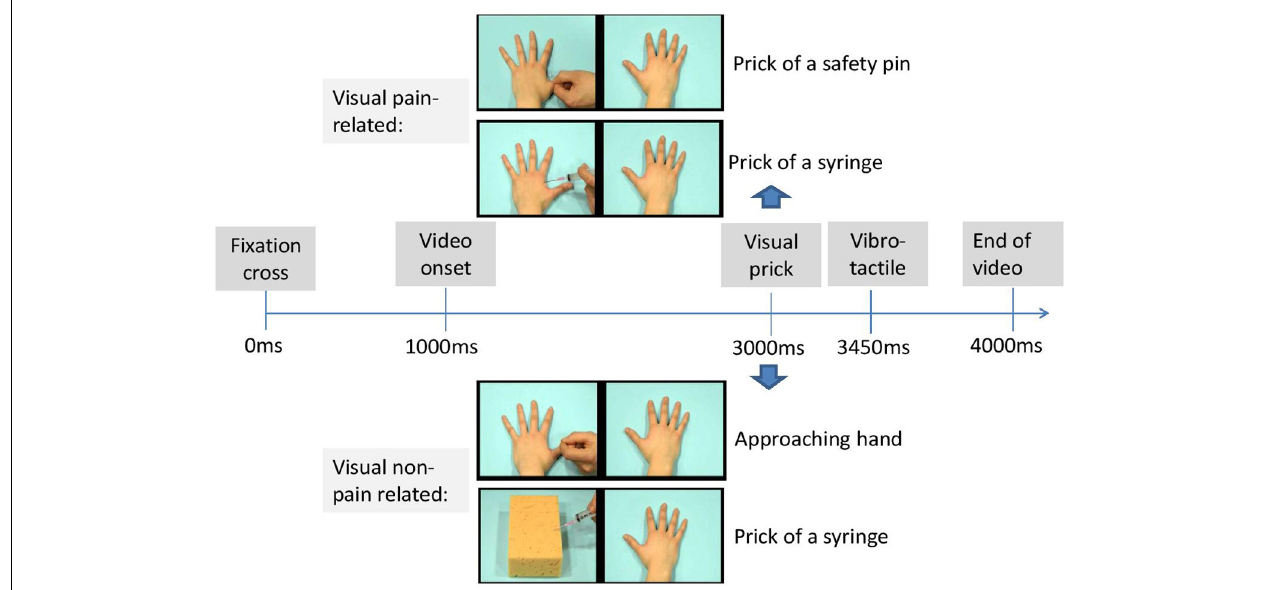
FIGURE 2 | Timeline of a possible